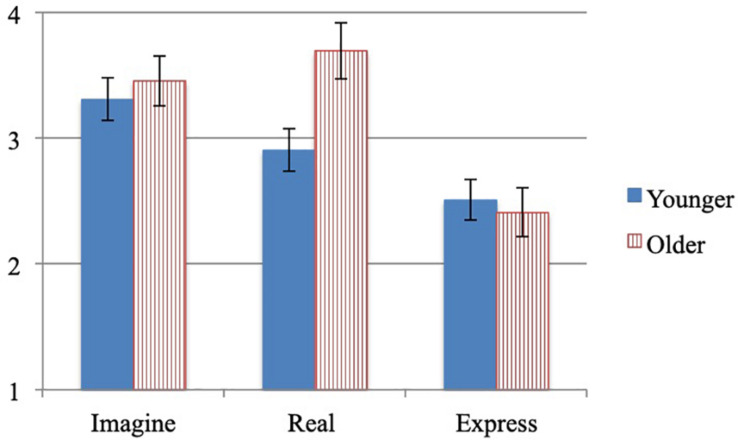
Study 2 mean absorption by condition and age group.